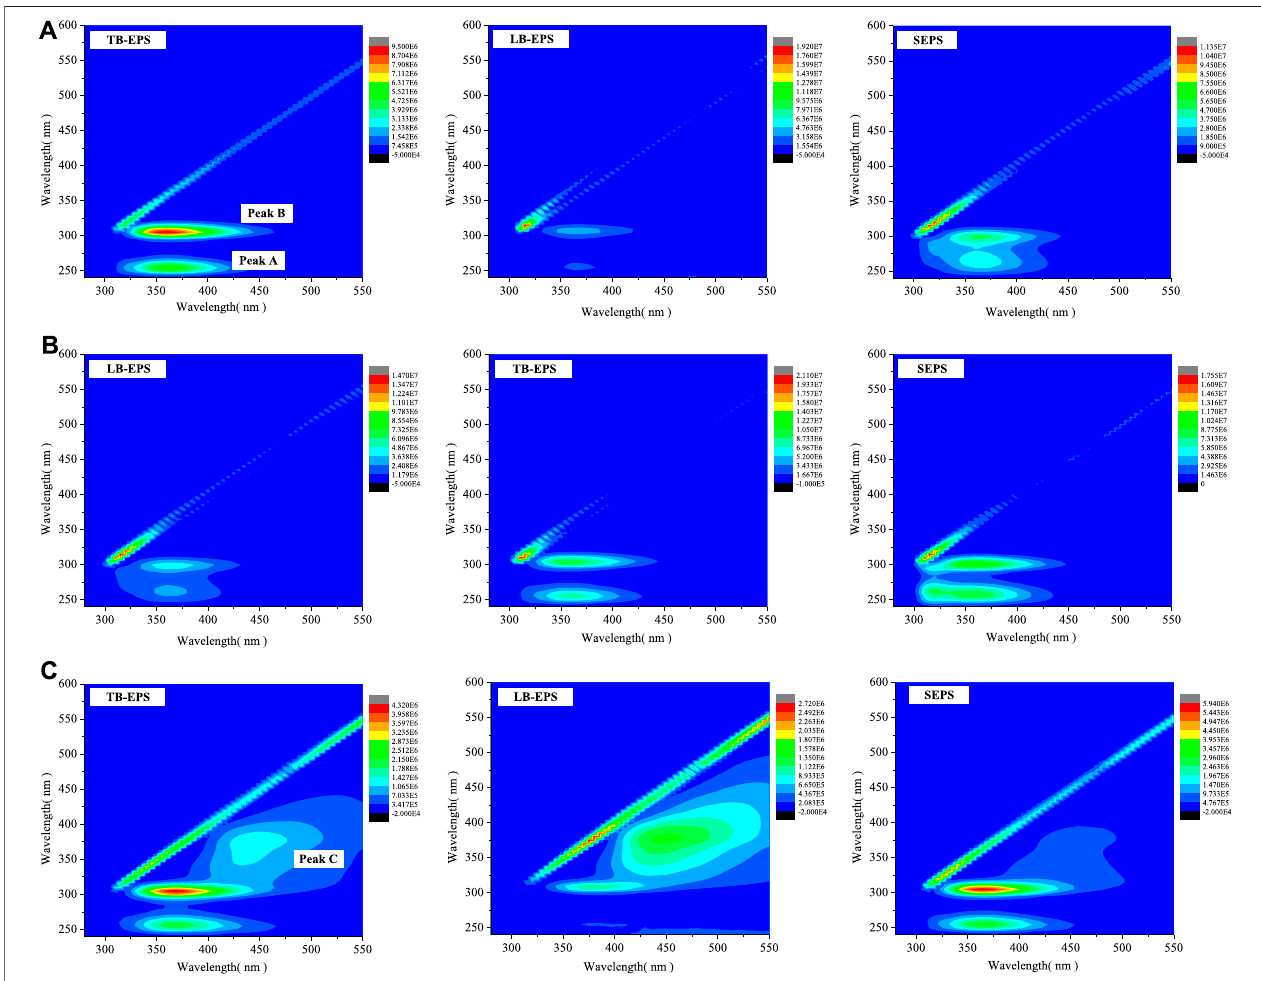
FIGURE5| Excitation – emissionmatrix fl uorescencespectraofthedifferentextracellularpolymericsubstance(EPS)fractions: (A) rawsludge; (B) sludgetreatedby CaO 2 (20 mg/gVSS)/MW(70 ° C); (C) sludge treated by CaO 2 (50 mg/gVSS)/MW(80 ° C).